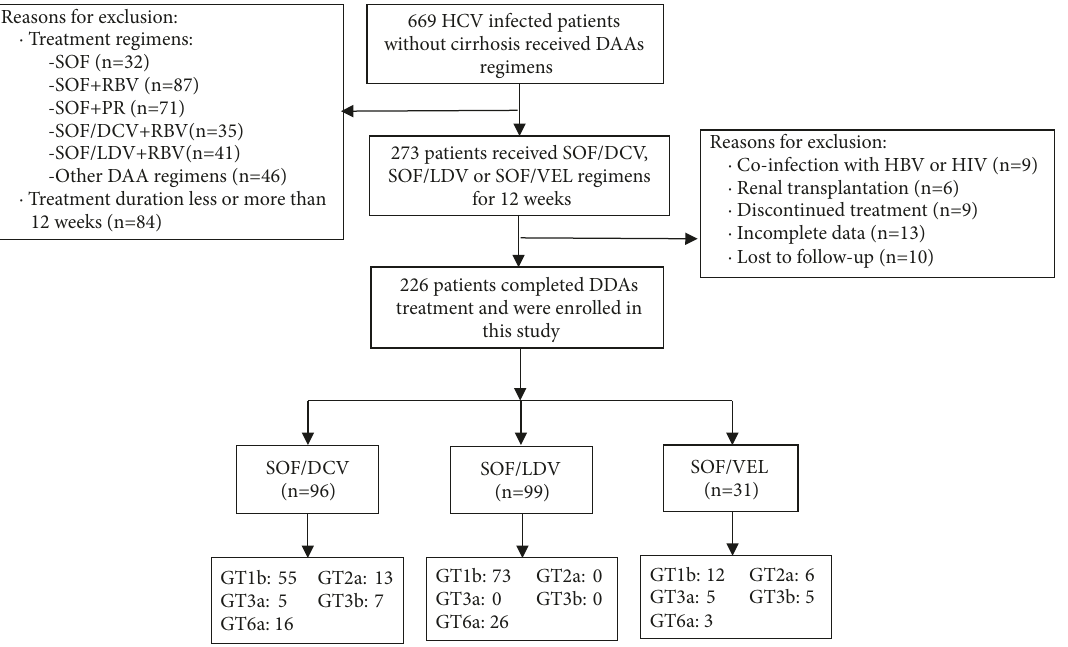
Figure 1: Patient recruitment